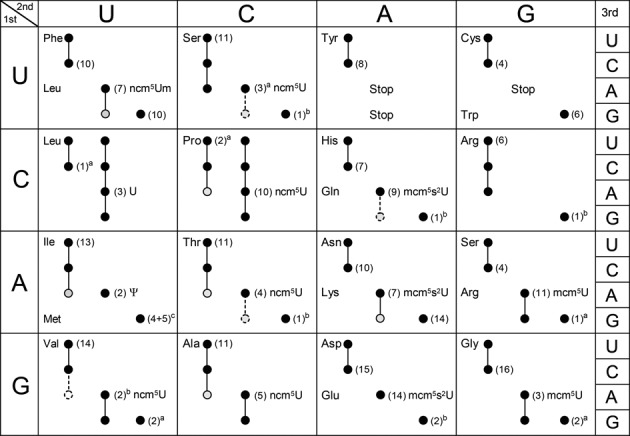
The genetic code and decoding abilities of individual tRNA species. Circles and connecting lines indicate codons read by the same tRNA isoacceptor. Gray circles connected with a dashed line indicate that the tRNA species reads the codon only when it is overexpressed. The empty dashed circle for \documentclass[12pt]{minimal}
\usepackage{amsmath}
\usepackage{wasysym}
\usepackage{amsfonts}
\usepackage{amssymb}
\usepackage{amsbsy}
\usepackage{upgreek}
\usepackage{mathrsfs}
\setlength{\oddsidemargin}{-69pt}
\begin{document}
}{}${\rm tRNA}_{{\rm IAC}}^{{\rm Val}}$\end{document} is shown only to indicate that this inosine containing tRNA species does not efficiently read the GUA codon. The nucleoside at the wobble position is given for the 13 wobble uridine containing tRNA species. Black and gray circles represent decoding abilities predicted by the wobble hypothesis, the revised wobble rules and the distribution of tRNA species. A gray circle indicates that the tRNA species is less likely to read the codon. The number of genes coding for a tRNA species is indicated next to the circle for the complementary codon. a The gene(s) encoding the tRNA is nonessential. b The gene(s) encoding the tRNA is essential. c Four genes code for \documentclass[12pt]{minimal}
\usepackage{amsmath}
\usepackage{wasysym}
\usepackage{amsfonts}
\usepackage{amssymb}
\usepackage{amsbsy}
\usepackage{upgreek}
\usepackage{mathrsfs}
\setlength{\oddsidemargin}{-69pt}
\begin{document}
}{}${\rm tRNA}_{\rm i}^{{\rm Met}}$\end{document}and five for \documentclass[12pt]{minimal}
\usepackage{amsmath}
\usepackage{wasysym}
\usepackage{amsfonts}
\usepackage{amssymb}
\usepackage{amsbsy}
\usepackage{upgreek}
\usepackage{mathrsfs}
\setlength{\oddsidemargin}{-69pt}
\begin{document}
}{}${\rm tRNA}_{\rm m}^{{\rm Met}}$\end{document}. Copyright © American Society for Microbiology, [Molecular and Cellular Biology, 28, 2008, 3301–3312 and doi:10.1128/MCB.01542–07](26).